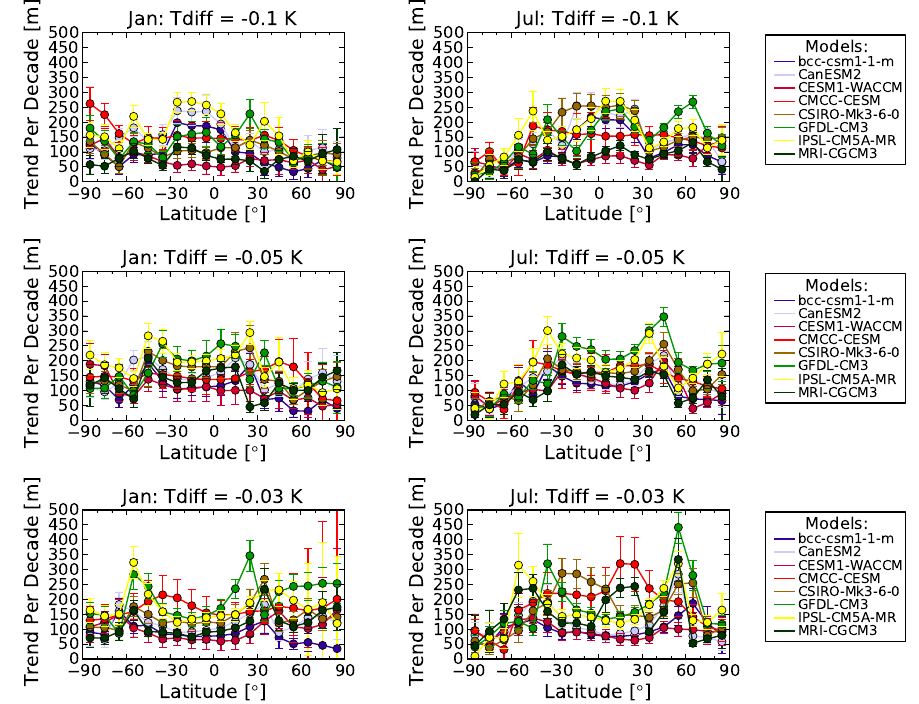
Figure 8. Height increase per decade (linear trend) and 95 % confidence interval for T diff = − 0 . 1 K (top), T diff = − 0 . 05 K (middle), and T diff = − 0 . 03 K (bottom) for January (left) and July (right), for the “max 8” CMIP5